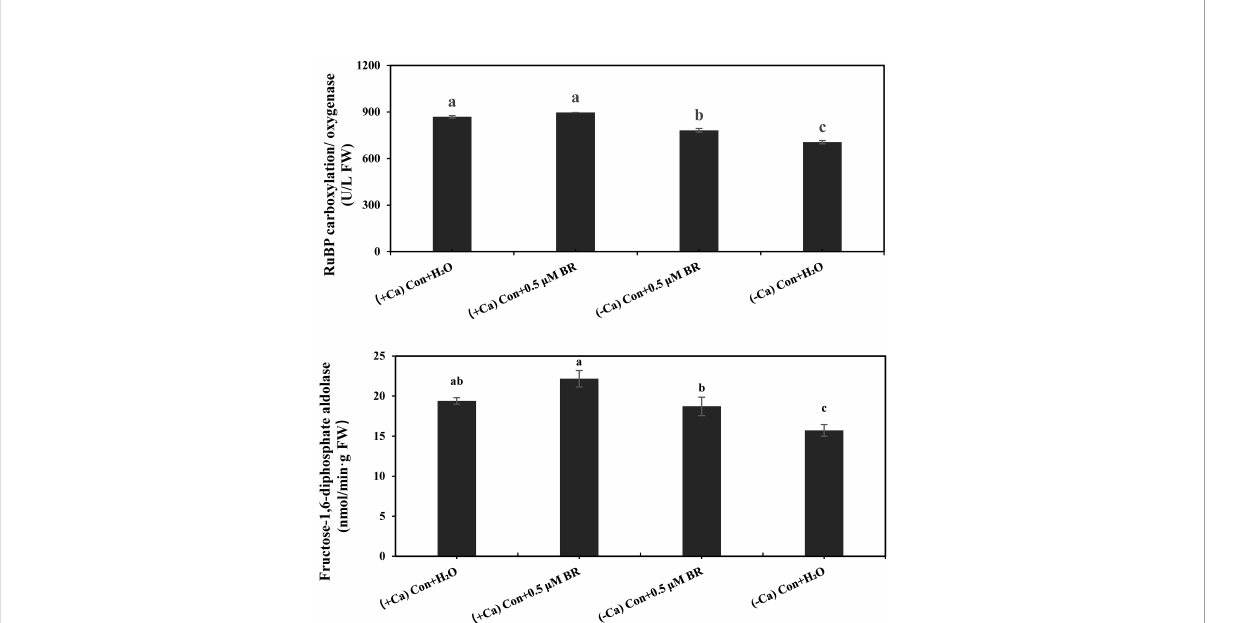
FIGURE 3 Effects of exogenous BRs on the activities of Rubisco and FBPase in mini Chinese cabbage leaves. Data are presented as mean ± SE (n=3). The different letters above the bars showed signi fi cantly different among treatments according to Duncan ’ s multiple test ( P<